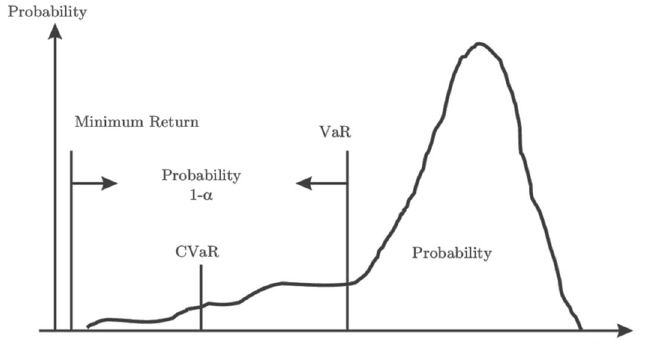
Fig. 1 The difference between VaR and